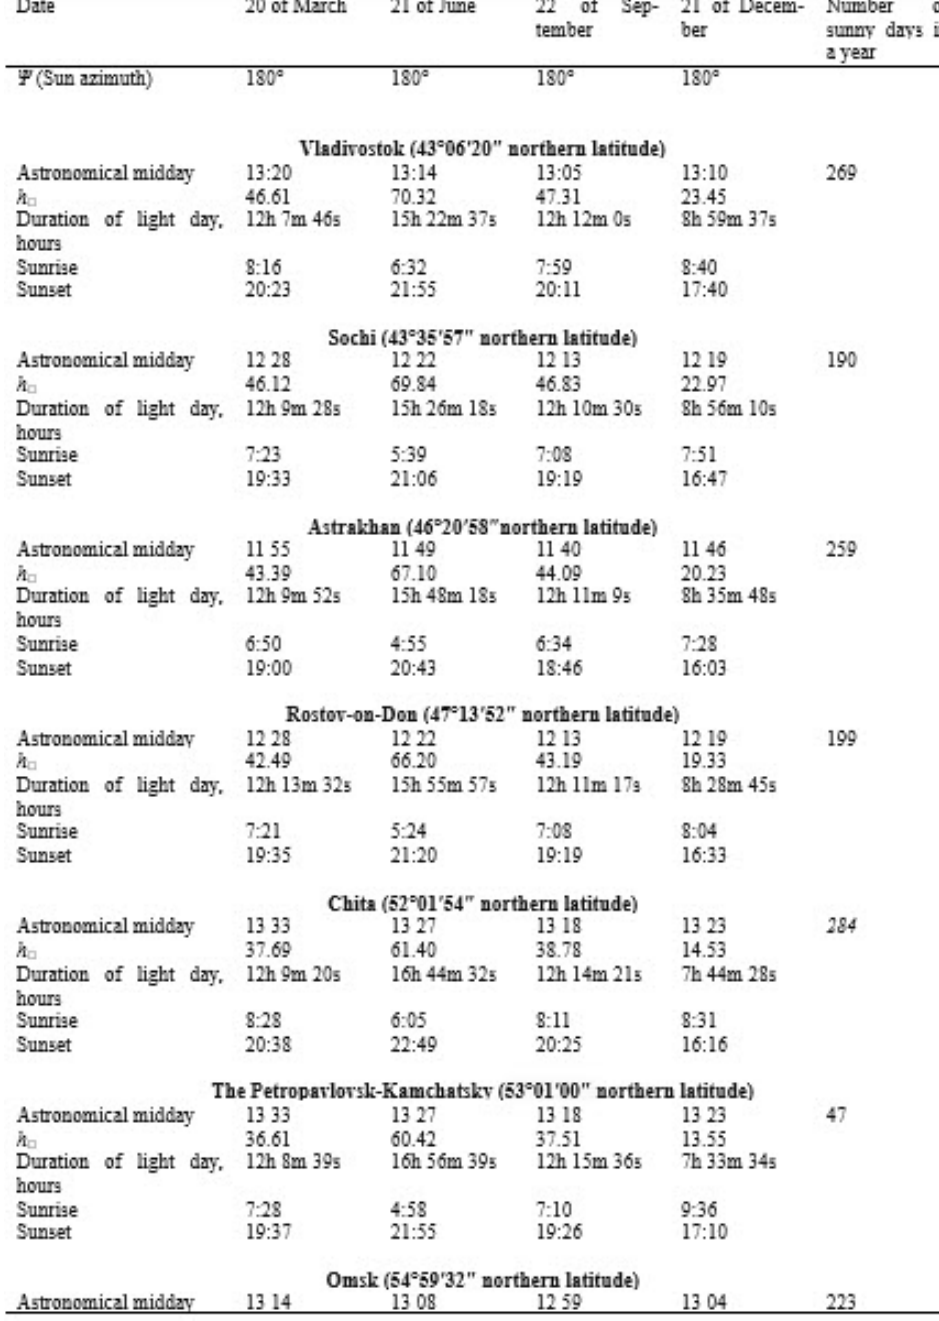
Table 2. Calculations of the angle of the Sun maximum rising over the horizon within a year for the cities of